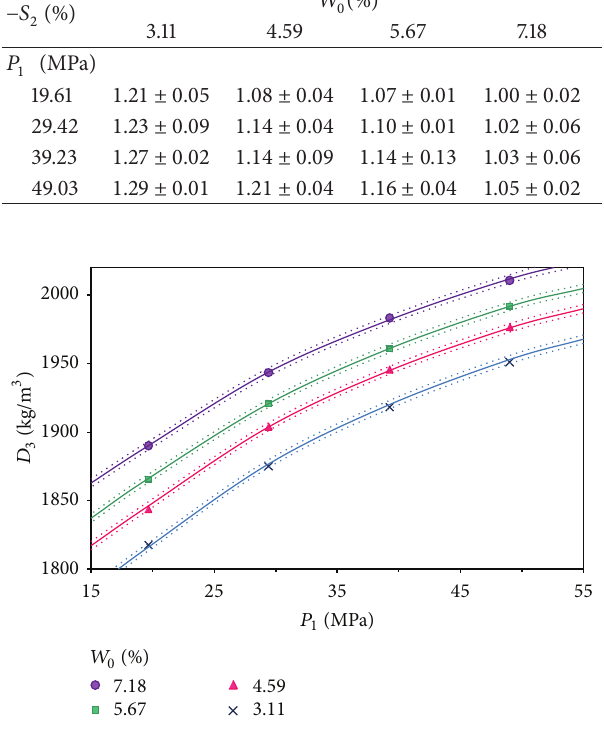
Figure 8: Dry bulk density ( 𝐷 3 ) as a function of the compaction pressure ( 𝑃 1 ) and powder moisture content ( 𝑊 0 ) with CI 95 % (dotted